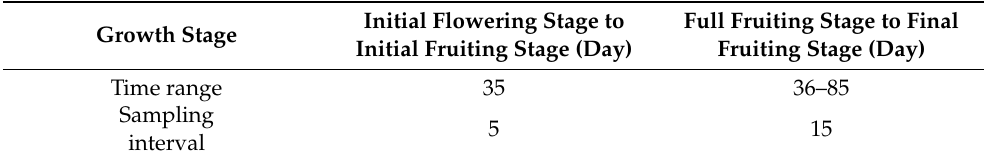
Table 2. Collection period setting of Full growth period.